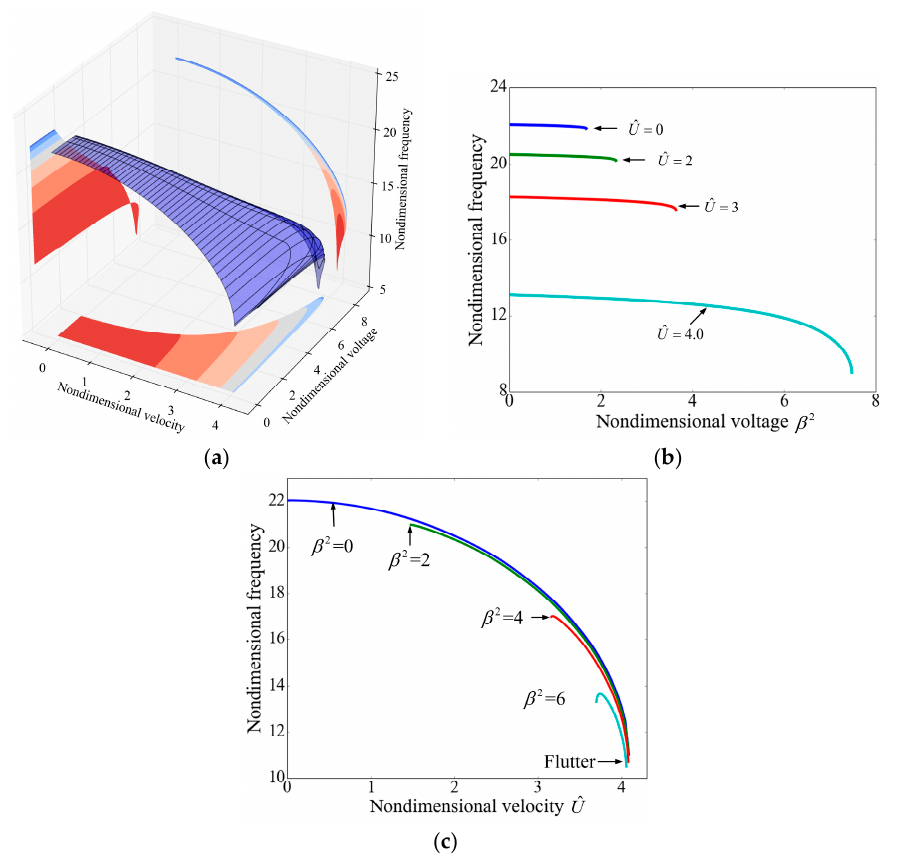
Figure 8. The frequency of the second mode as a function of the nondimensional voltage and the nondimensional velocity ( a ) The effect of both applied voltage and fluid velocity on the resonant frequency; ( b ) The effect of voltage on the frequency for different fluid velocities; and ( c ) The effect of velocity on frequency for different applied